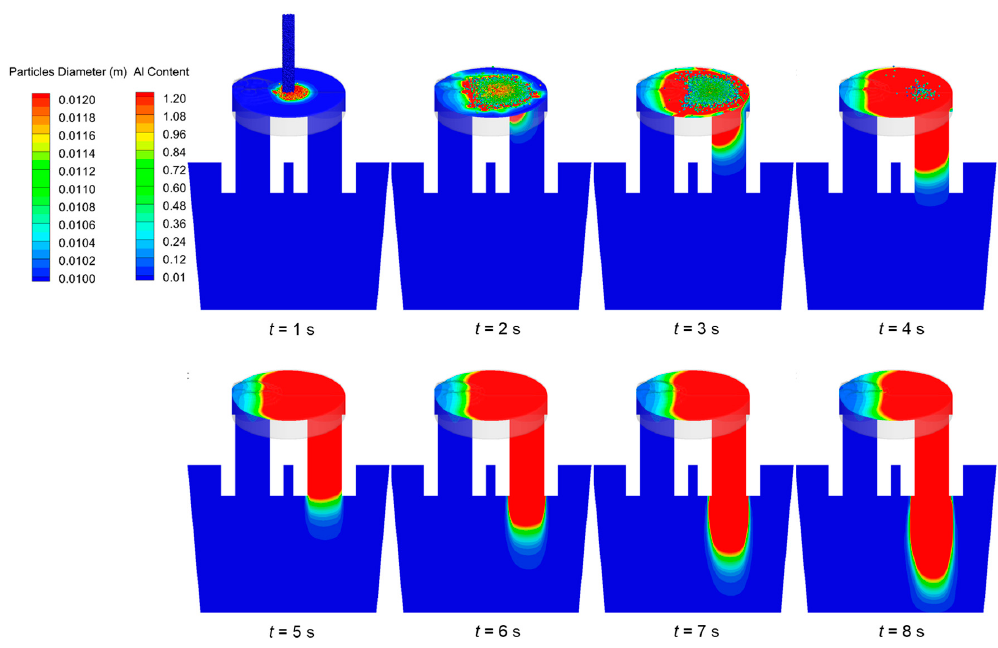
Figure 3. Evolution of added aluminum particles and dissolved aluminum in molten steel.